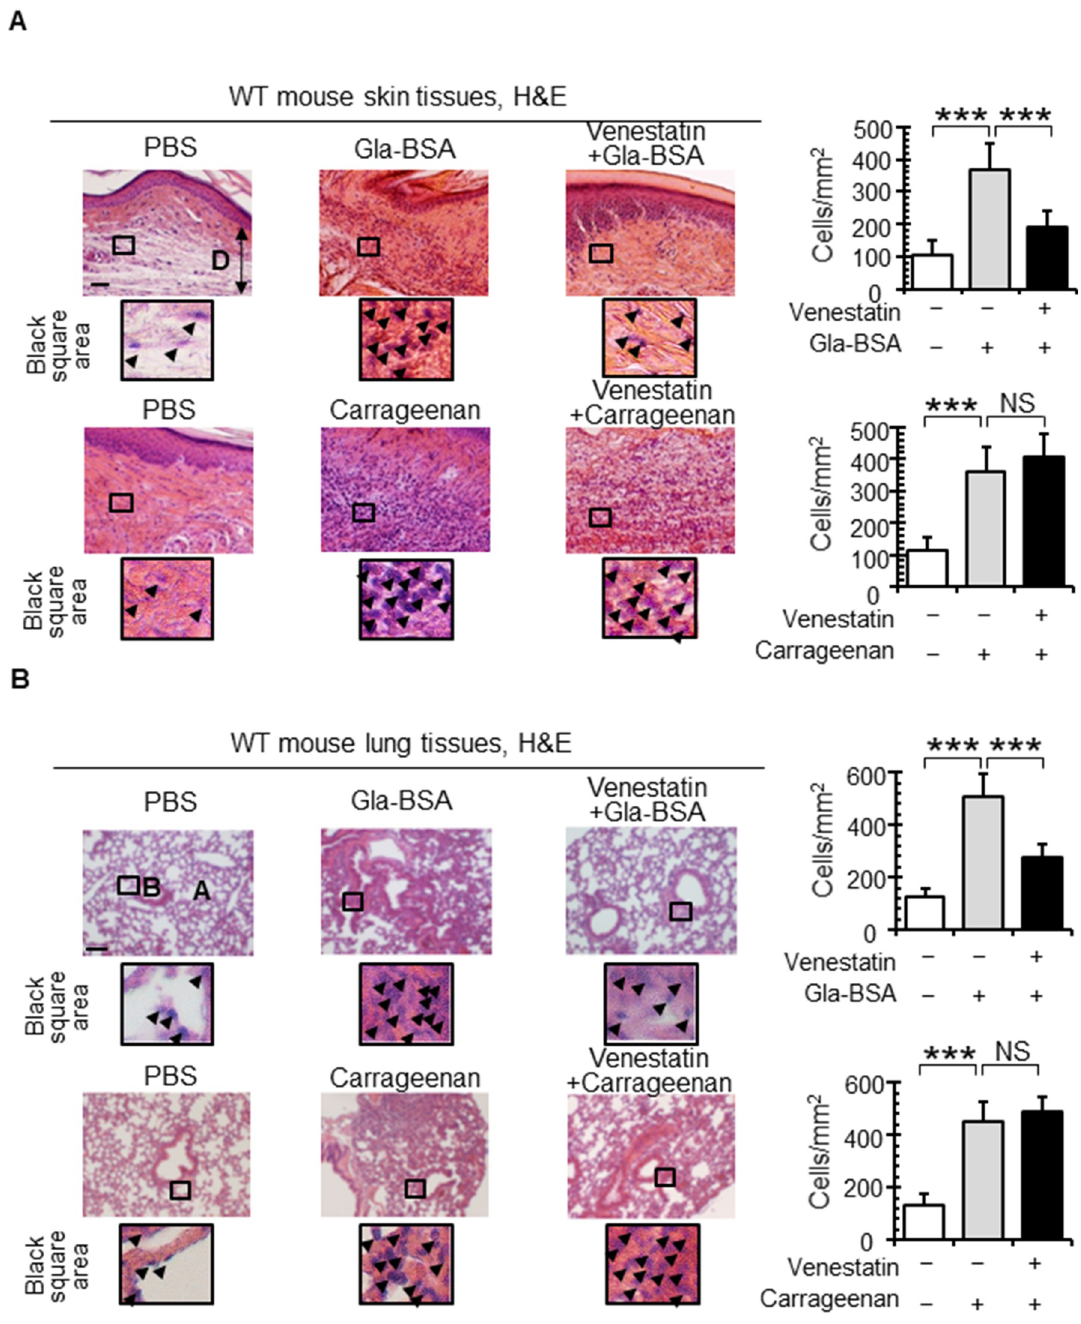
Fig 2. Venestatin alleviated RAGE/ligand-mediated inflammation. (A) Venestatin attenuated Gla-BSA-induced mouse footpad inflammation. Venestatin (100 μ g) or PBS was injected into the hind footpad of each mouse, followed by injection with Gla-BSA (100 μ g), 2% carrageenan, or PBS into the same footpad. After 8 h, the footpads were collected, fixed, and sections were stained with H&E. Black squares indicate magnified insets marking examples of inflammatory cells (arrow heads). White bars indicate the number of cells in PBS controls. D, dermal tissue. (B) Venestatin attenuated Gla-BSA-induced pneumonia in mice. Venestatin (50 μ g) or PBS was instilled intranasally, followed by intranasal instillation with Gla-BSA (50 μ g), 2% carrageenan, or PBS. After 48 h, the lungs were collected, fixed, and sections were stained with H&E. Black squares indicate magnified insets marking examples of inflammatory cells (arrow heads). White bars indicate the number of cells in PBS controls. A, pulmonary alveolus; B, bronchus lumen. Scale bar: 40 μ m. Data are expressed as means ± SDs of 12 fields in two mice. ��� p < 0.0001. NS, no significant difference.